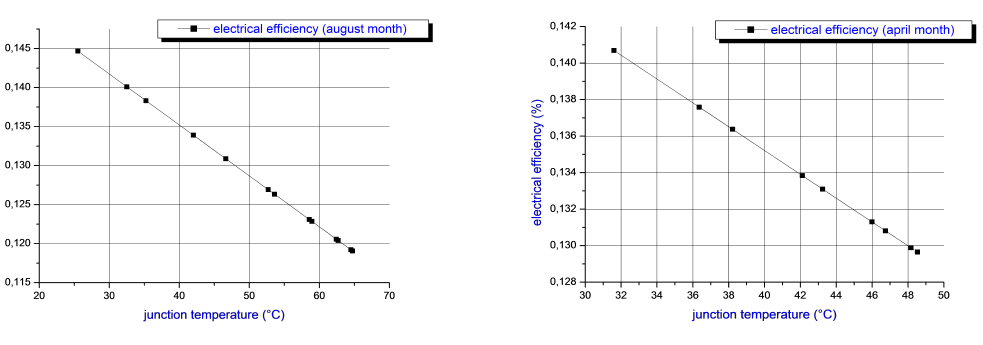
Fig. 8: Evolution of the electrical e(cid:30)ciency as a func- tion of the junction temperature for n = 228 and under a pure sky.